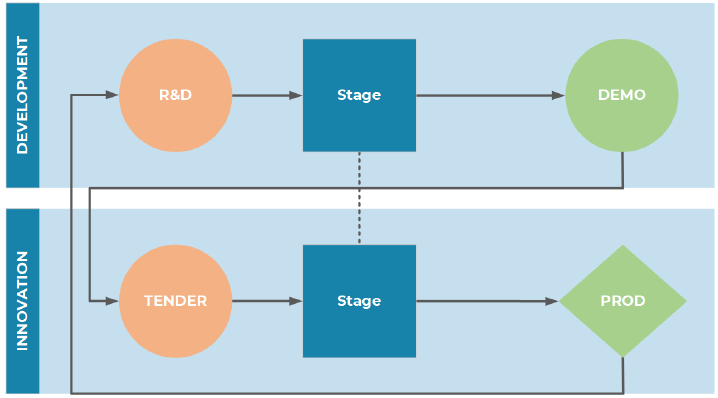
Figure 2. Development Line Concept.